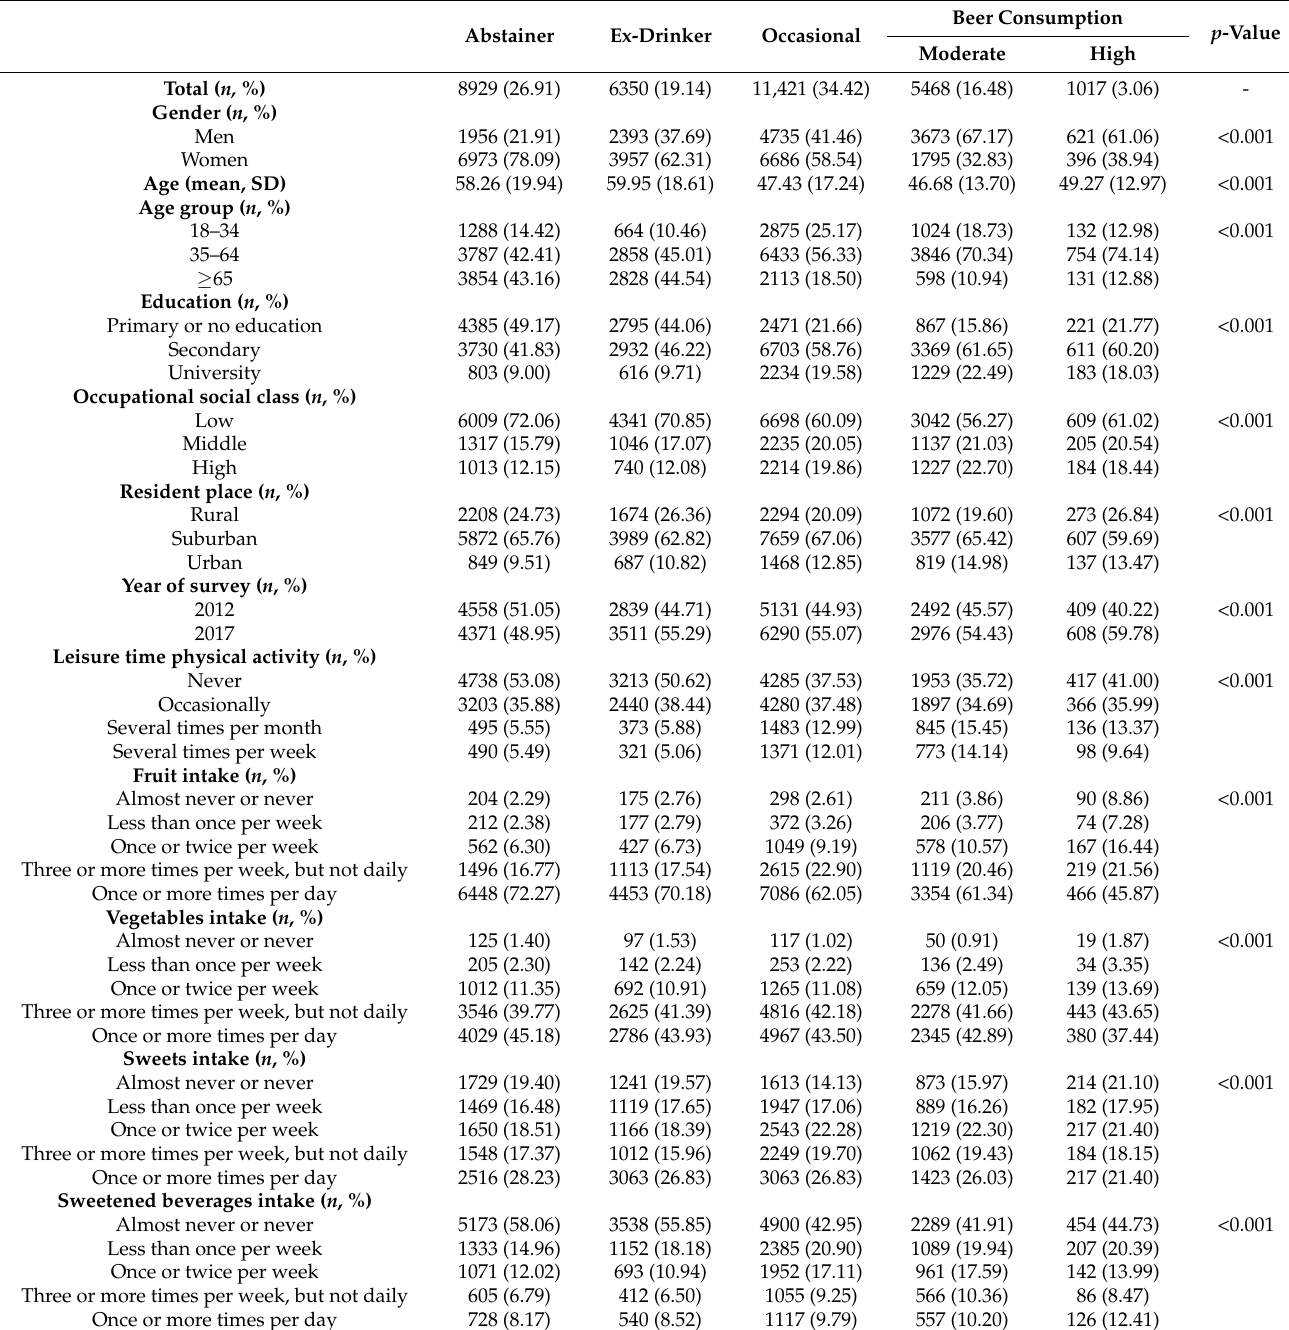
Table 1. Socio-demographic and health-related lifestyle characteristics across beer consumption levels ( ≥ 18 years), Spanish National Health Surveys 2012,